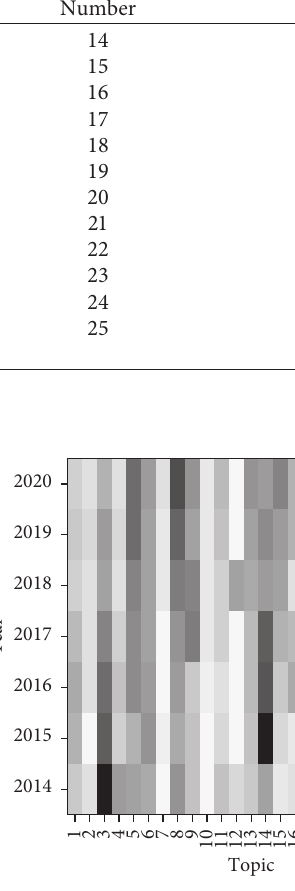
Figure 8: Trend of evolutionary weight of each technology